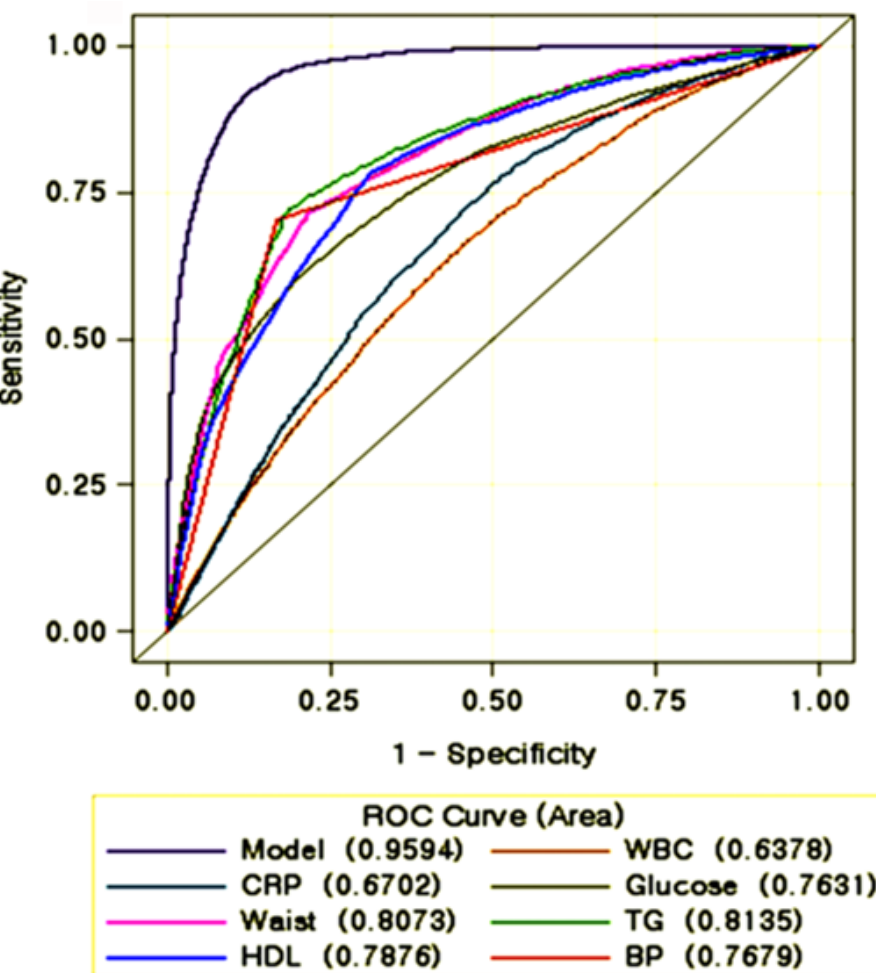
Figure 1. Receiver operating characteristic (ROC) curve with white blood cell (WBC) counts and serum C-reactive protein (CRP) concentrations for metabolic syndrome risk.